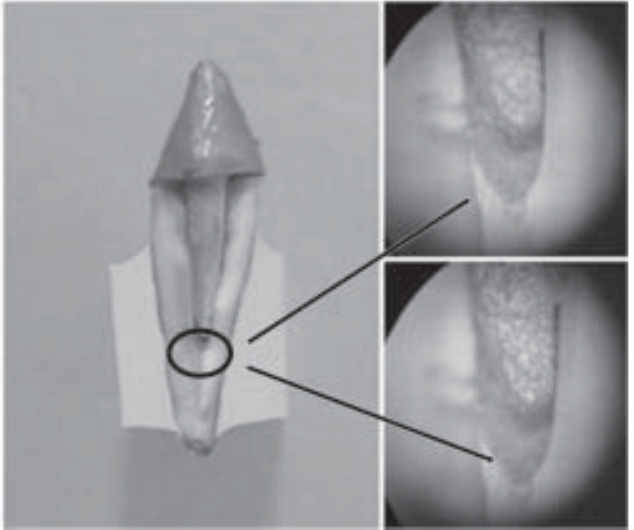
Figure 1. Distance between the apical portion of the CMC and the residual filling material, as observed in the microscopic analysis.